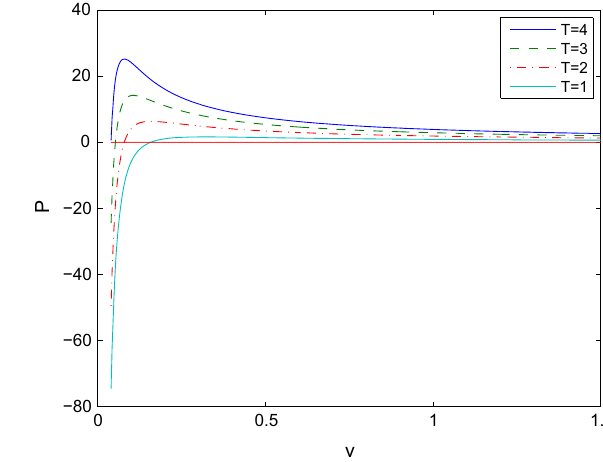
Fig. 5 The plot of the critical temperature T c vs β at q m = 1